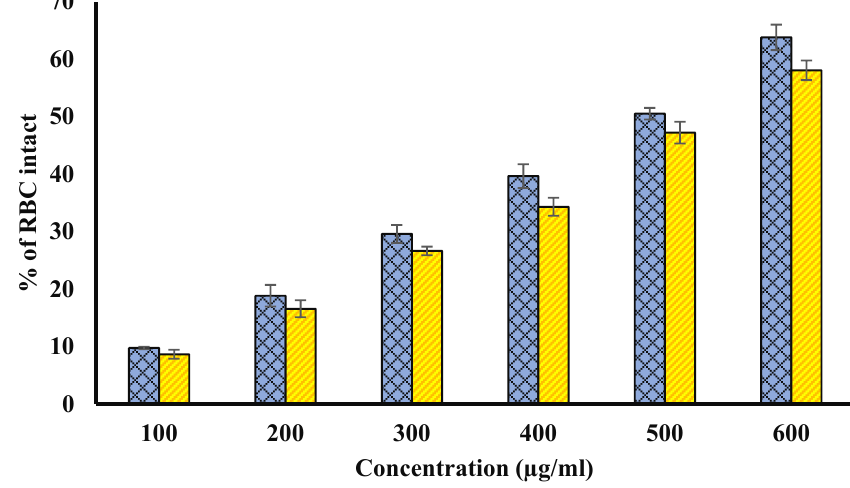
Figure 7. Percentage of RBC intact. Blue columns represent various concentrations (100–600 µg/mL) of Ajwa fruit pulp. Yellow columns represent various concentrations (100–600 µg/mL) of Ajwa seed extract. The results are presented as means ± SEM ( n = 3, p < 0.05).